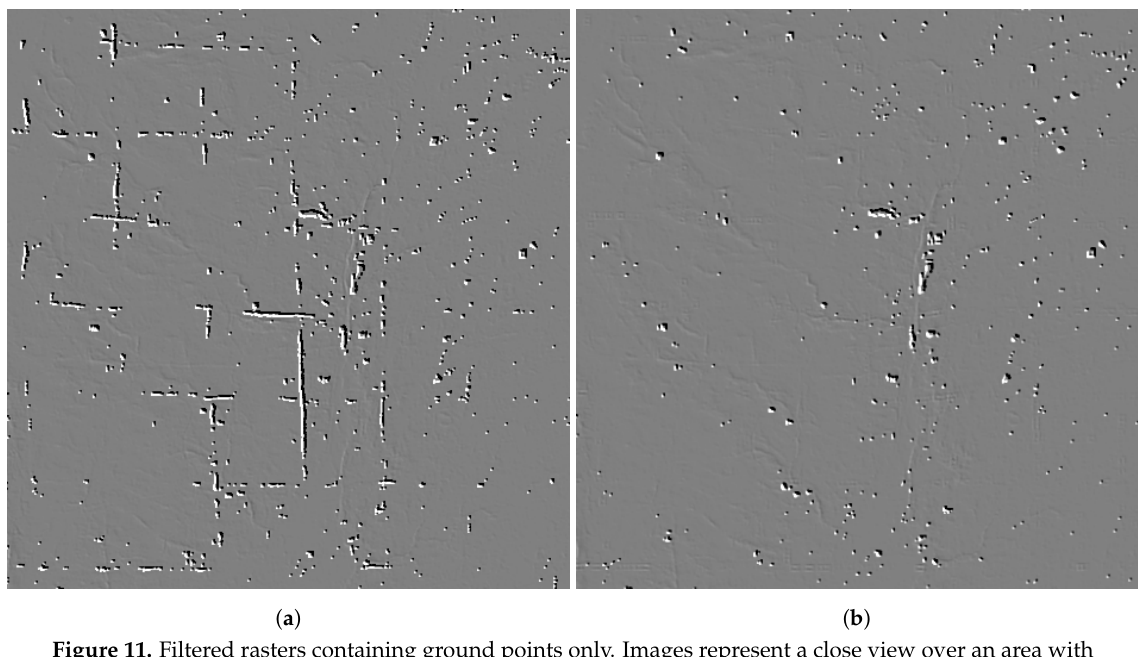
Figure 11. Filtered rasters containing ground points only. Images represent a close view over an area with 16 zones (8 × 8 on 16 km 2 ) from the dataset D3. ( a ) (NO-EC) The are several errors in the form of large white artificial gaps between zones. ( b ) (EC) Errors are gone once our strategy was applied. Remaining white gaps correspond to large areas of buildings or forests.